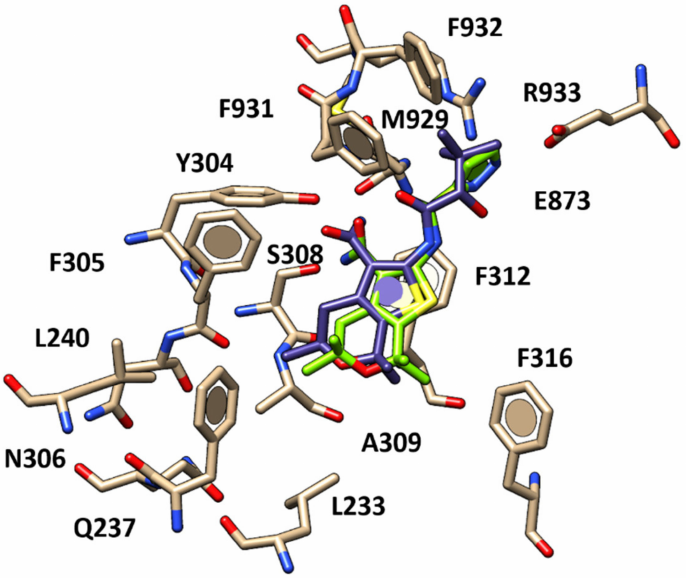
Figure 7. Docking positioning of compound 20 ( C atom; deep purple) compared to that of compound 11 ( C atom; green) within the human CFTR